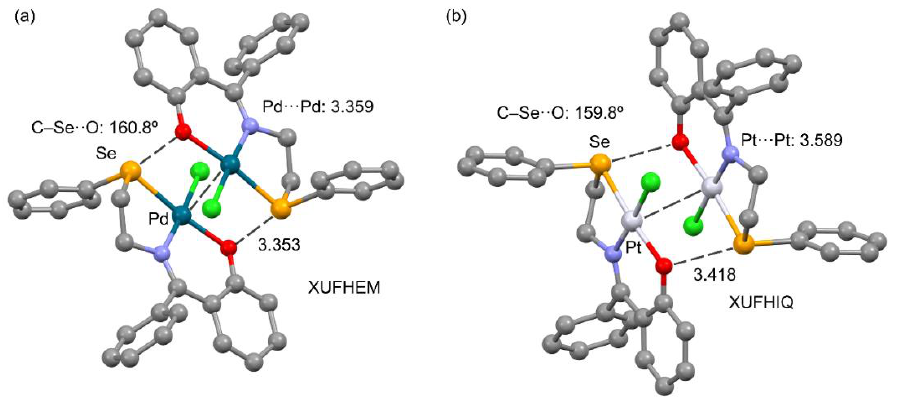
Figure 4. Partial views of the refcodes XUFHEM ( a ) and XUFHIQ ( b ) structures. Distances in Å. H-atoms omitted for